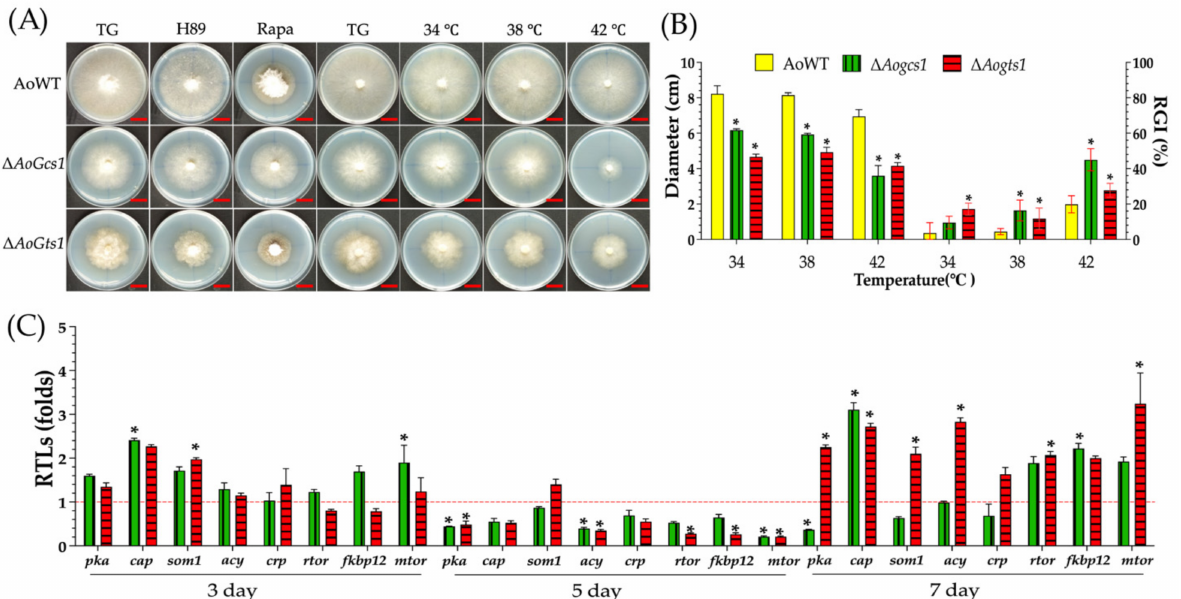
Figure 5. Comparison of rapamycin, H89, and heat shock sensitivity in the WT and mutant strains. ( A ) Colony morphologies of the WT and mutant strains cultured in the presence of 10 ng/mL rapamycin or 10 µ M H-89. Bar = 2 cm. ( B ) Colony diameters and the relative growth inhibition (RGI) values for the WT and mutant strains cultured at a temperature of 34–42 ◦ C. ( C ) Relative transcription levels (RTLs) of the cAMP/PKA, TOR, and MAPK signaling pathway-related genes in the mutants when compared with the WT strain at different time points. The red line indicates the standard (which has an RTL of 1) for statistical analysis of the RTL of each gene in a deletion mutant compared to that in the WT strain. The asterisk indicates a significant difference between the mutants and the WT strain (Tukey’s HSD, p <